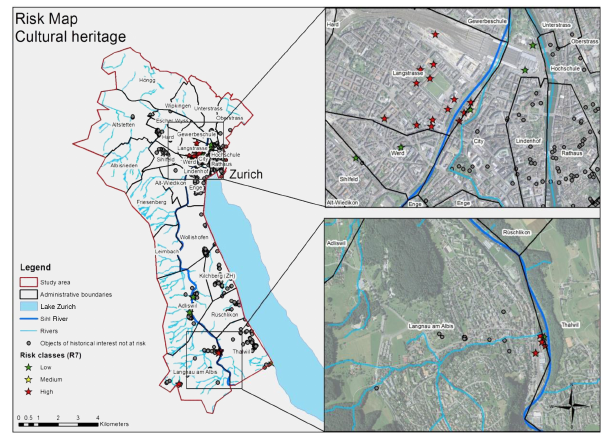
Figure 10. Relative risk map for natural and semi-natural systems (left) with two insets showing details on the most affected area (right).